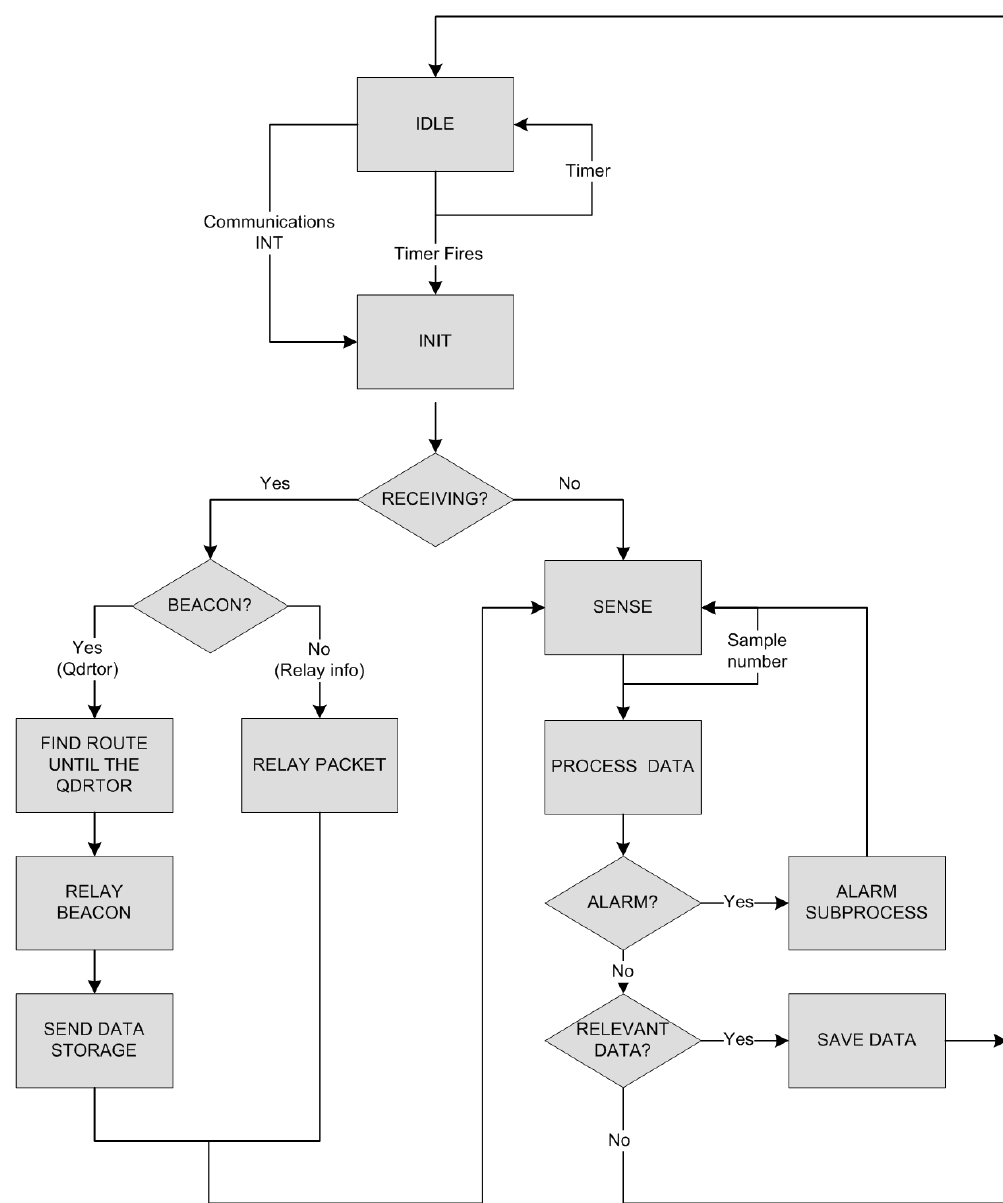
Figure 5. WSN mesh